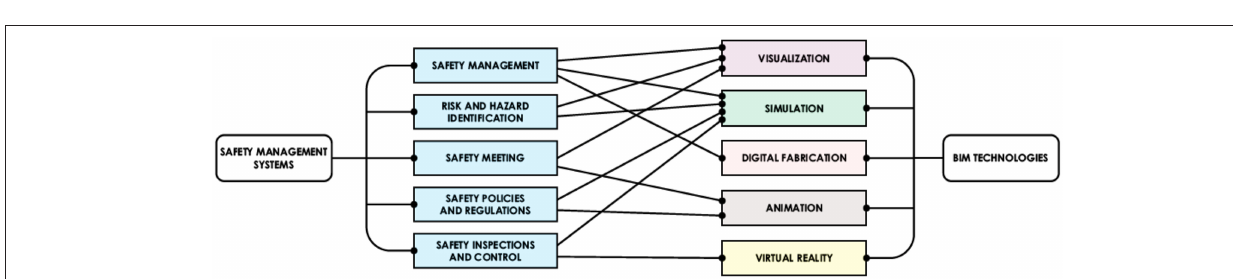
FIGURE 5 | Relationships between BIM technologies and safety management system.